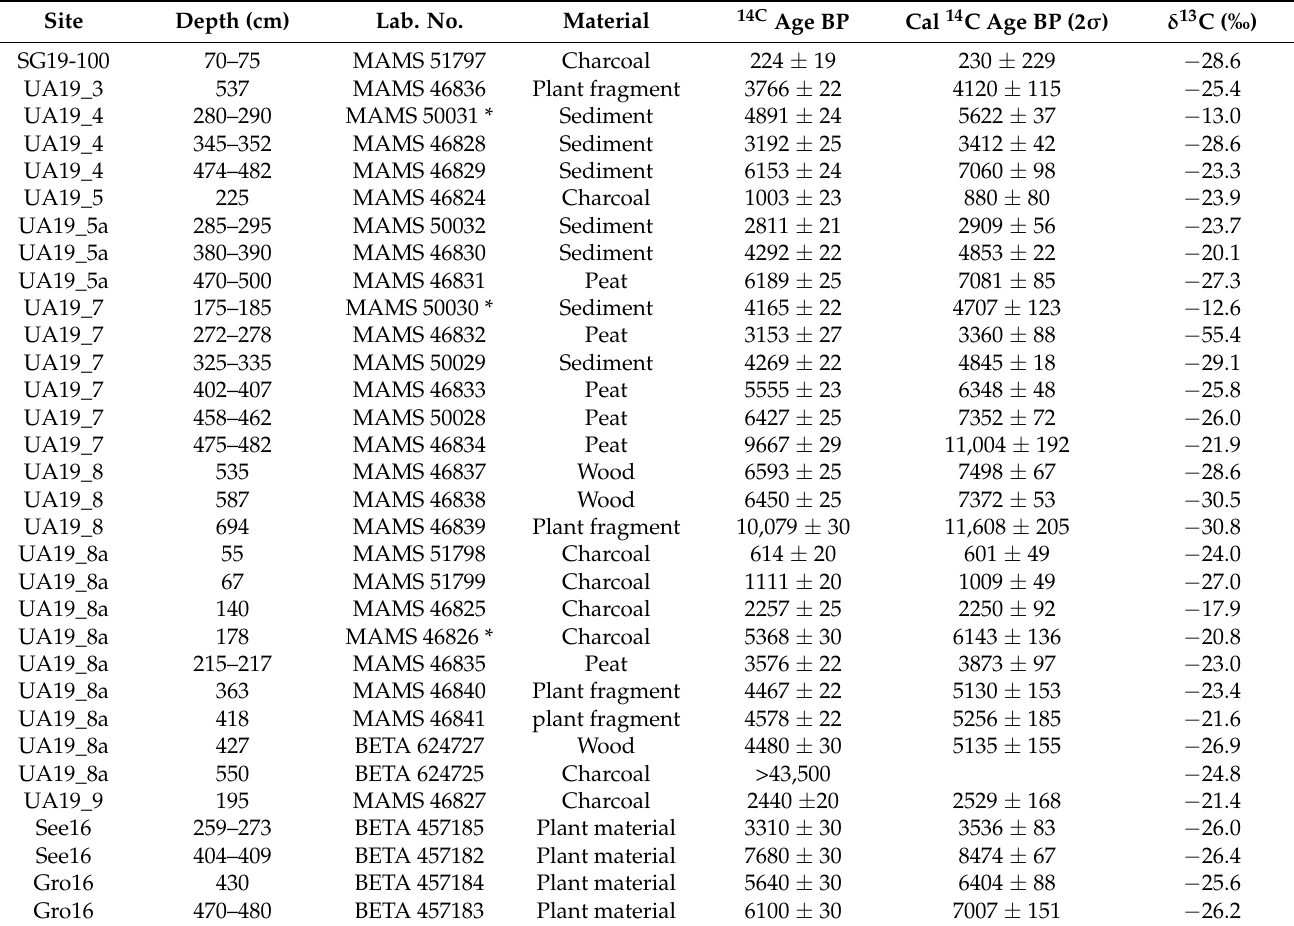
Table 1. Results of radiocarbon dating.